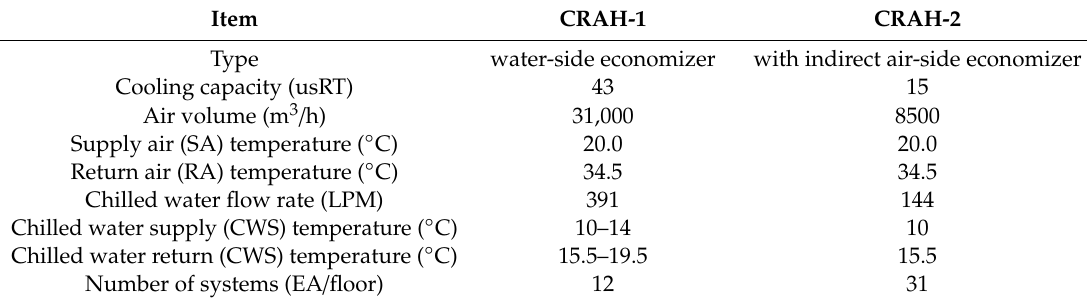
Figure 7. Data center cooling system: ( a ) secondary chilled water loop; ( b ) IT server room on a typical floor. Table 2. Information technology (IT) cooling system operating conditions.